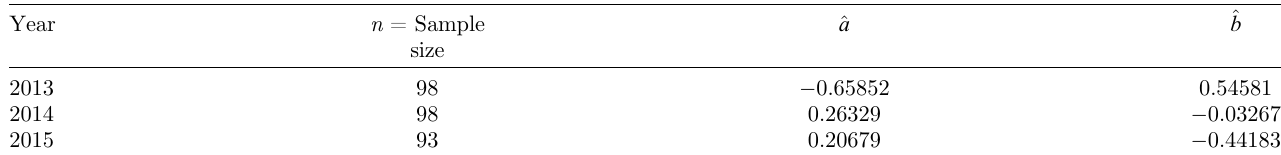
Table 2. Bayesian estimators of a and b – see De fi nition